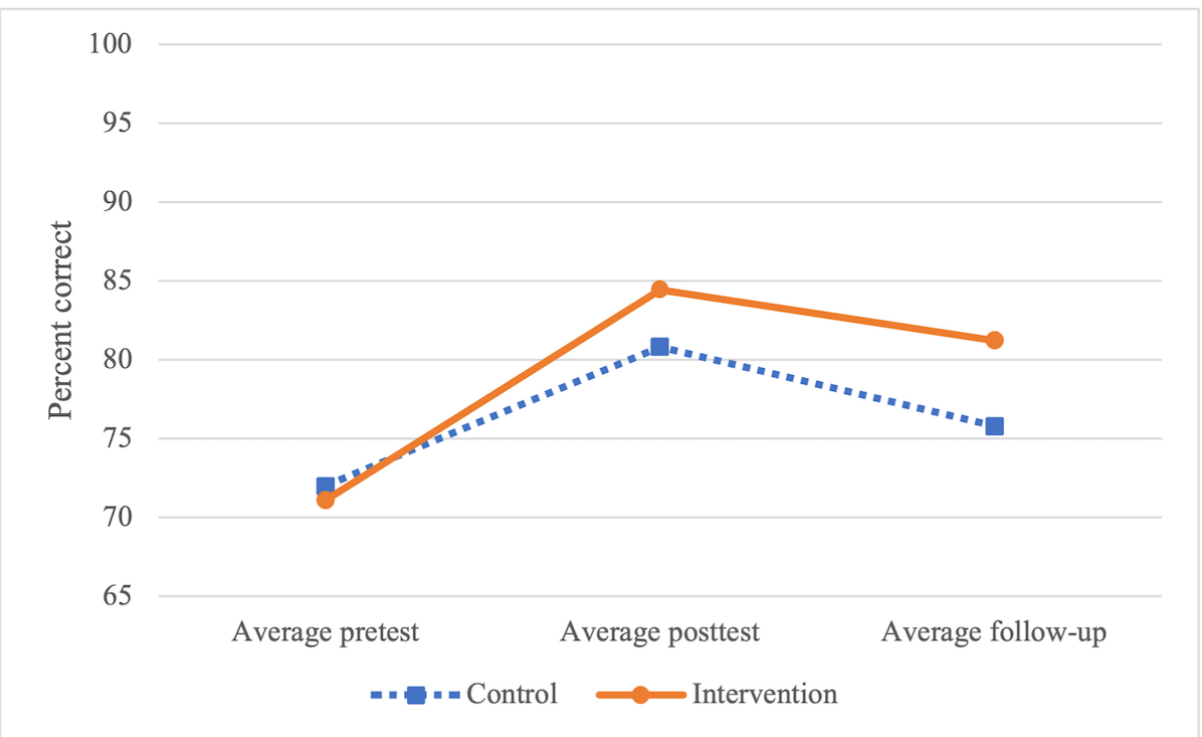
Figure 3. Average education test scores for pretest, posttest, and 2-month follow-up.